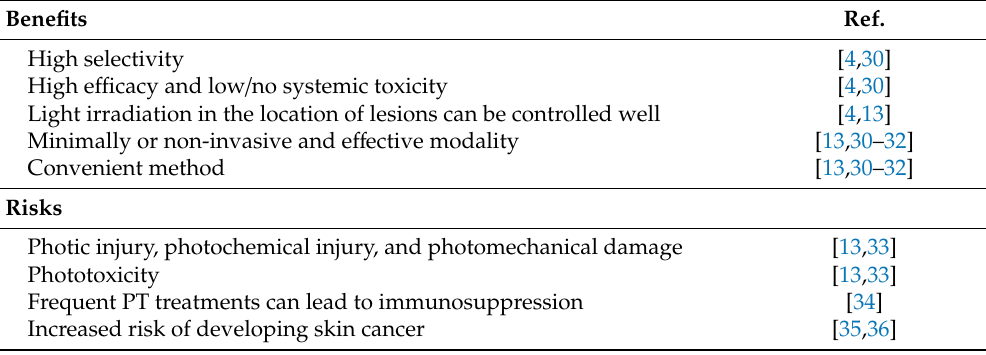
Table 1. Benefits and risks of photo-based imaging and